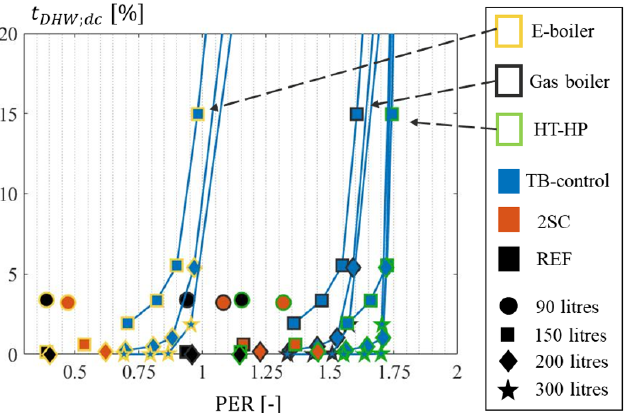
Figure 11. The DHW discomfort and PER for different high-temperature units. The face colour refers to the used control strategy (black for reference control, red for 2SC and blue for TB-control) and the edge colour to the used HT-unit (black is a gas boiler, yellow for the e-boiler, and green for the